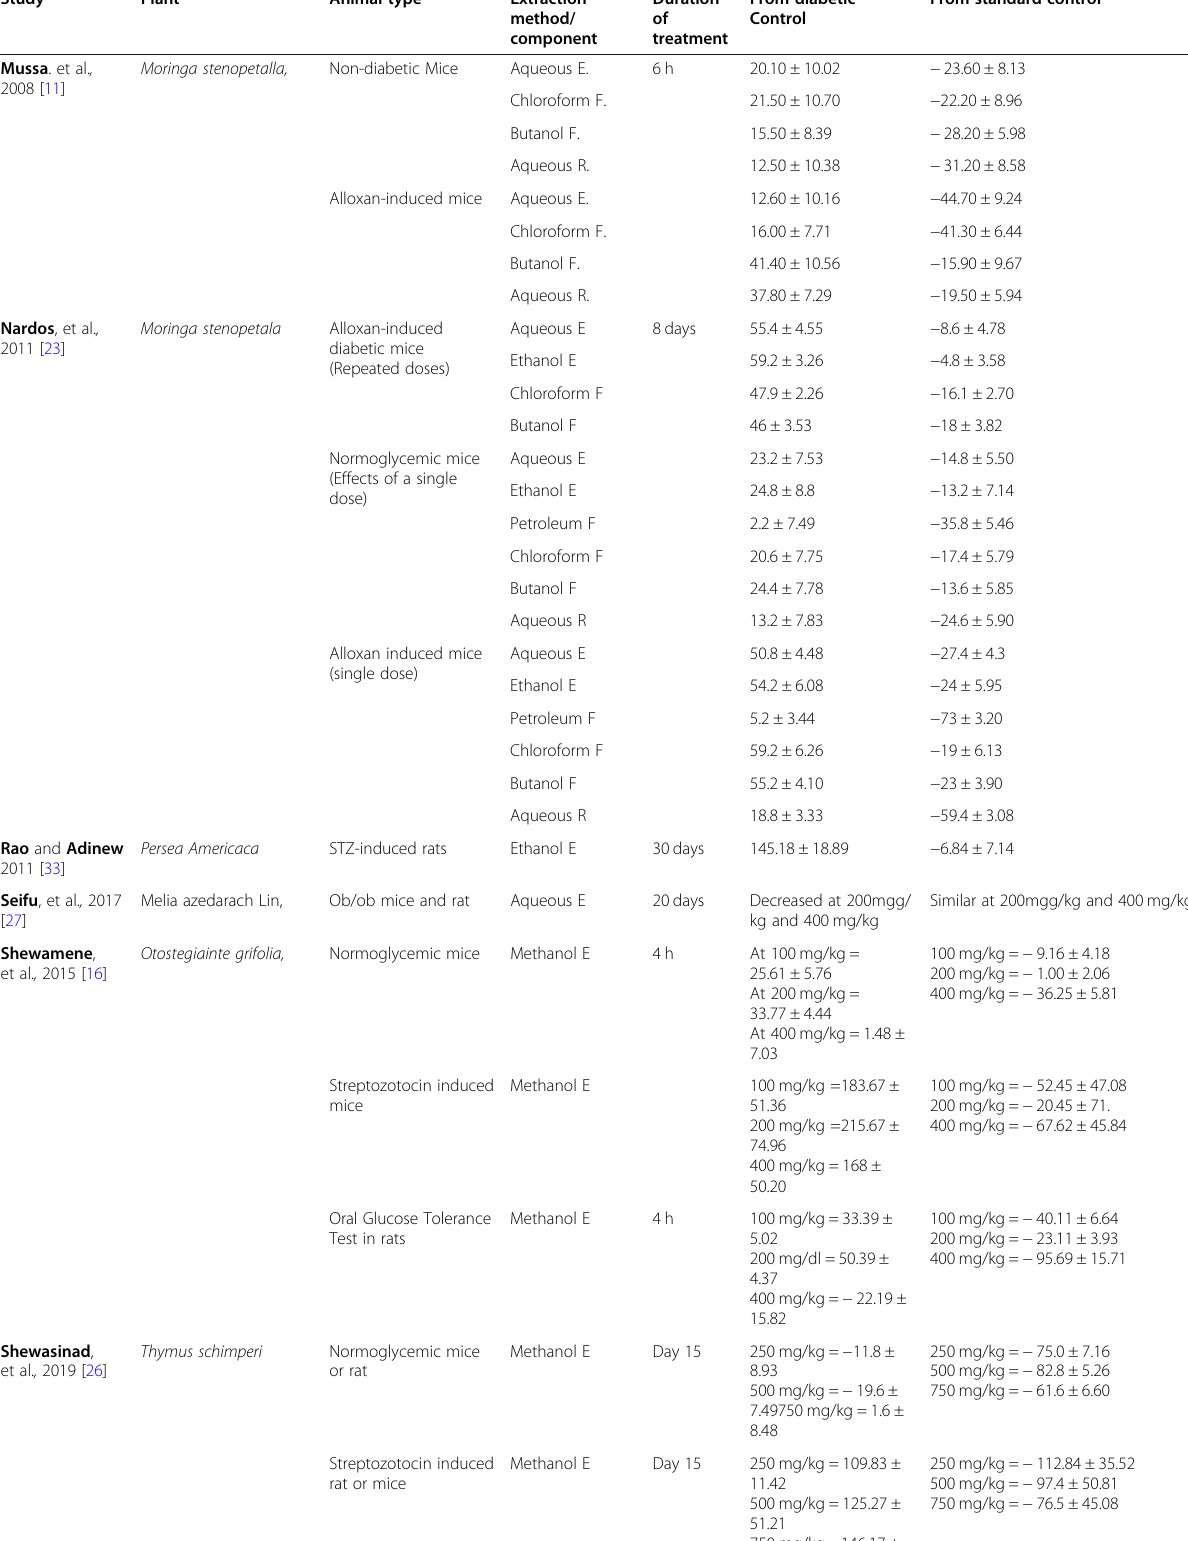
Table 3 In vivo anti-diabetic activity of medicinal plat in Ethiopia (Continued)